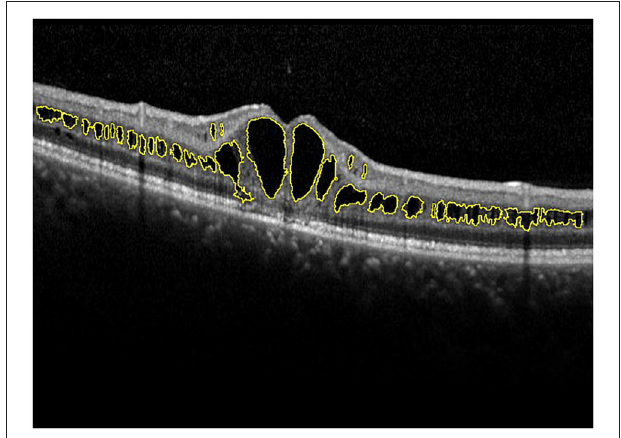
FIGURE 2 | Manual measurement of the area of macular schisis cavity (AMS). The macular schisis cavities were marked by yellow lines and the results were computed by ImageJ software.